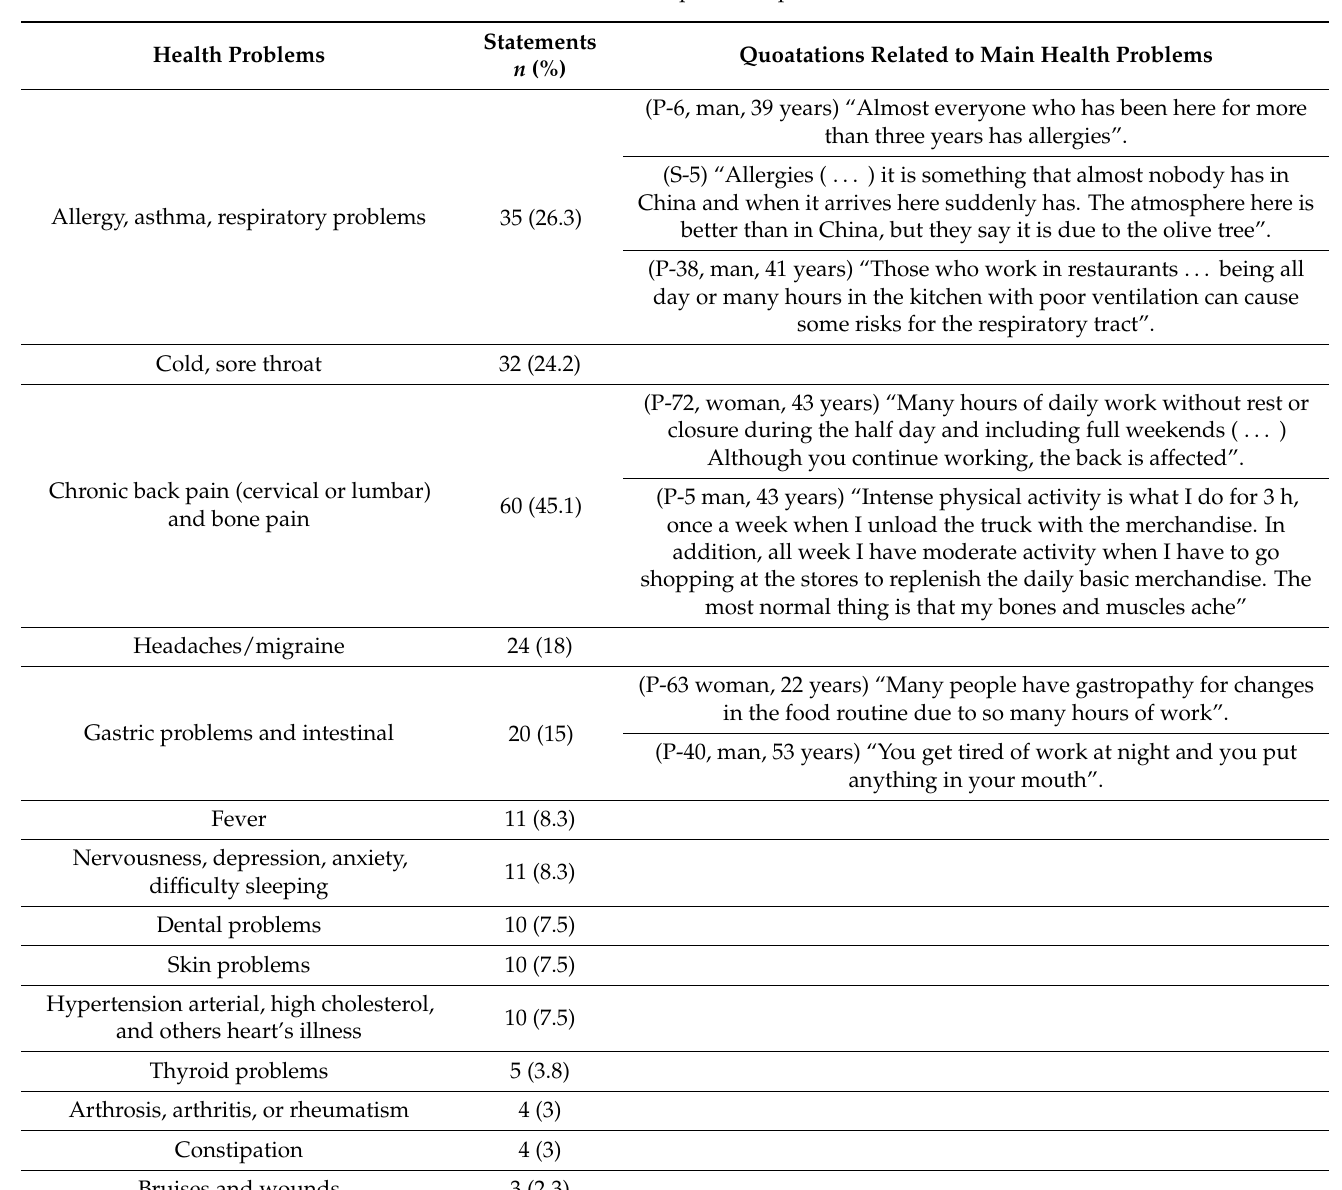
Table 4. Main health problems